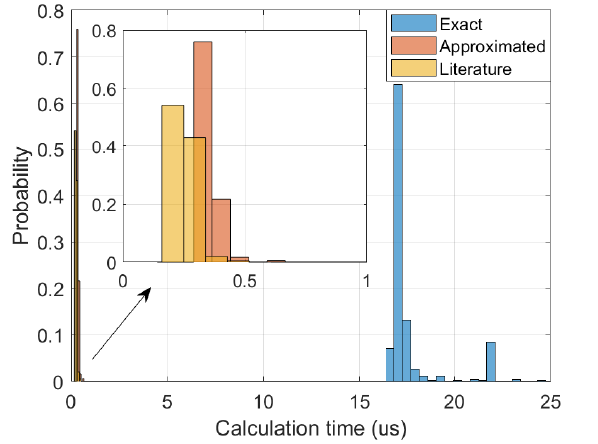
Figure 11. Calculation time histograms for the three formulations, for a ball screw with r m = 8 mm, r b = 1.5875 mm, p = 20 mm, ϕ = 45 deg, H = 0.0629 mm and L = 0.0505